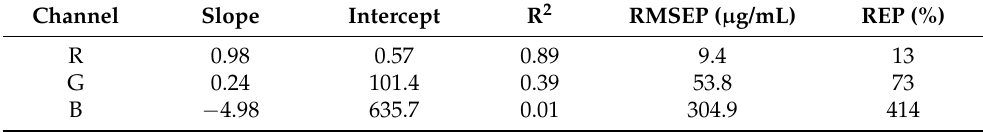
Table 1. Figures of merit for the univariate regression obtained in the different channels. Channel